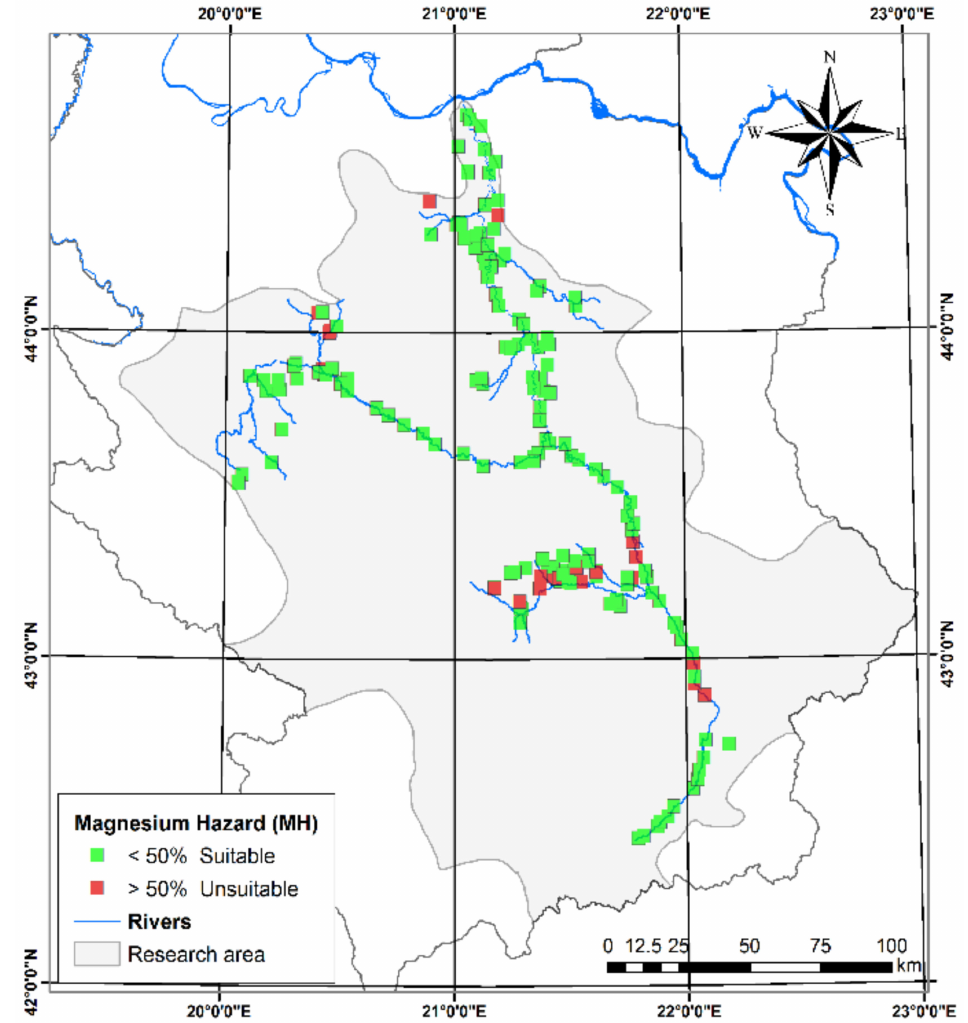
Figure 13. Spatial distribution of